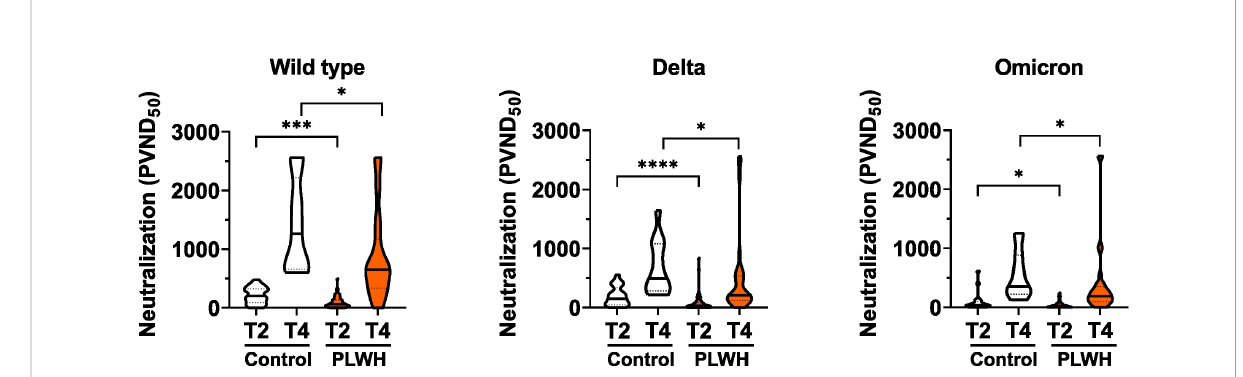
FIGURE 2 Neutralizing antibodies to SARS-CoV-2. Vero E6 cells were infected with the respective pseudoviruses in the presence of serial dilutions of sera. The pseudotype virus neutralization dose 50% (PVND50) is plotted. Neutralizing antibodies against the SARS-CoV-2 strains Wild type (PLWH T2, n = 70; Control T2, n = 20; Control T4, n = 13; PLWH T4, n = 33), Delta (PLWH T2, n = 65; Control T2, n = 20; Control T4, n = 13; PLWH T4, n = 33) and Omicron (PLWH T2, n = 70; Control T2, n = 20; Control T4, n = 13; PLWH T4, n = 33) were tested. Statistical signi fi cance was calculated by two-tailed Mann-Whitney test: *p < 0.05, ***p < 0.001, ****p <